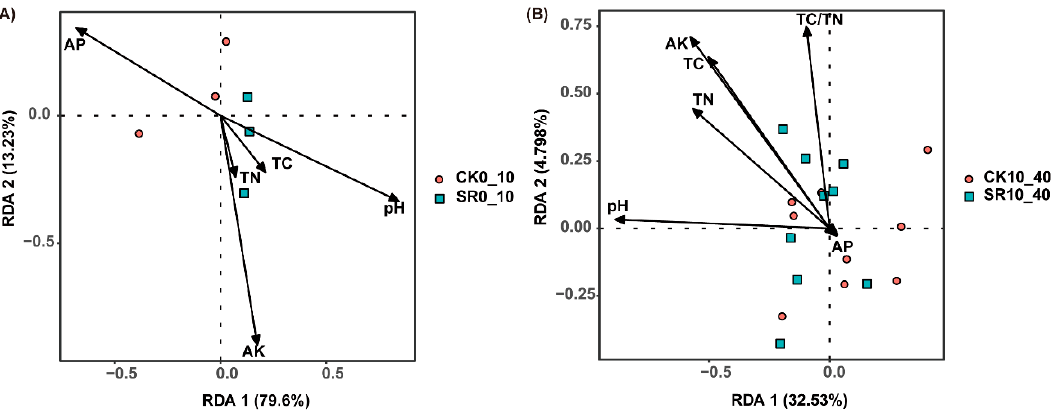
Figure 4. Redundancy analysis (RDA) of bacterial communities and measured soil properties at 0–10-cm ( A ) and 10–40-cm ( B ) depths. CK, control; SR, sugarcane straw retention.